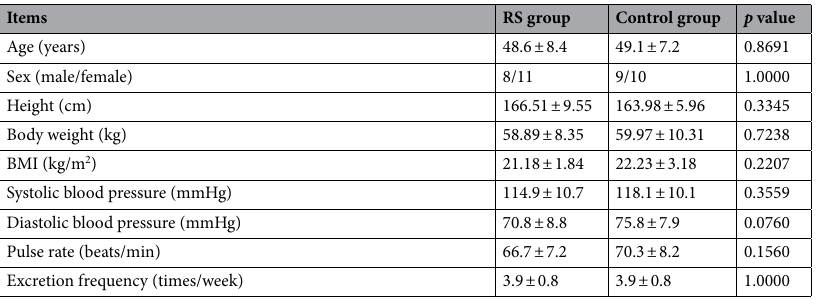
Table 1. Base line characteristics in human subjects. RS (n = 19), Control (n = 19). Mean ± SD. p -value: unpaired t-test.